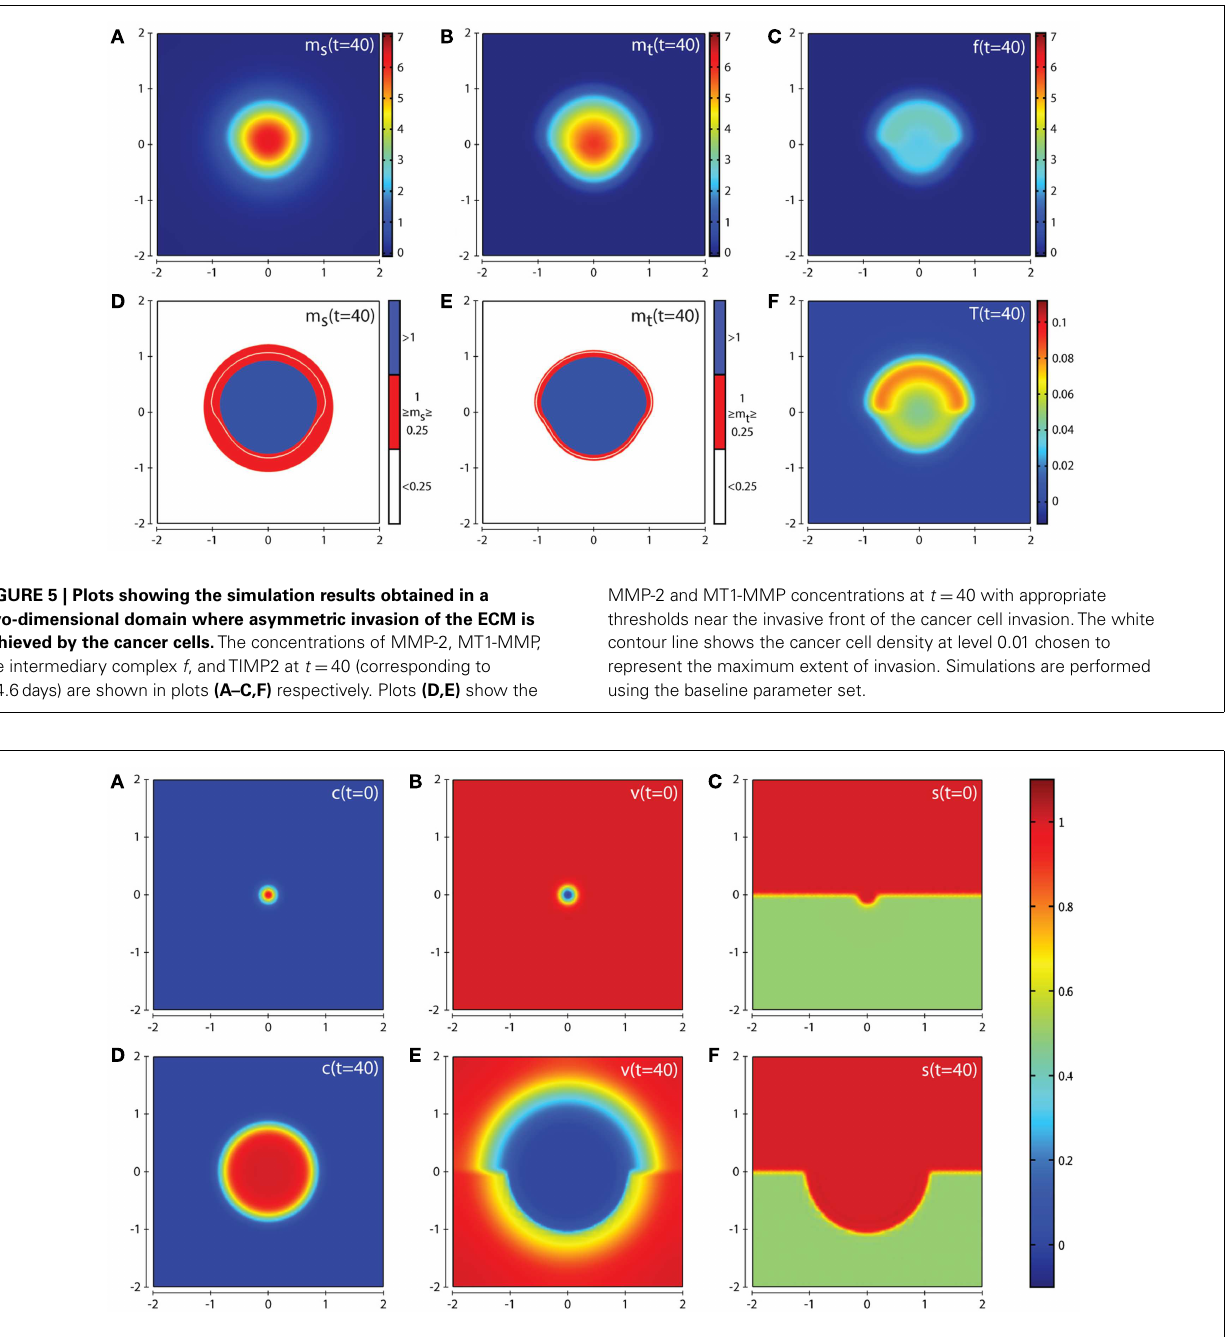
baseline parameter set with the exception of δ s = 10. Plots (A–C) show the initial values of the cancer cell and ECM densities as well as the initial layout of the matrix suitability modifier with plots (D–F) showing their resultant profiles at t = 40 (corresponding to ∼ 4.6days). As can be seen, in this case there is an almost symmetric invasion pattern.This shows the influence of the parameter δ s on